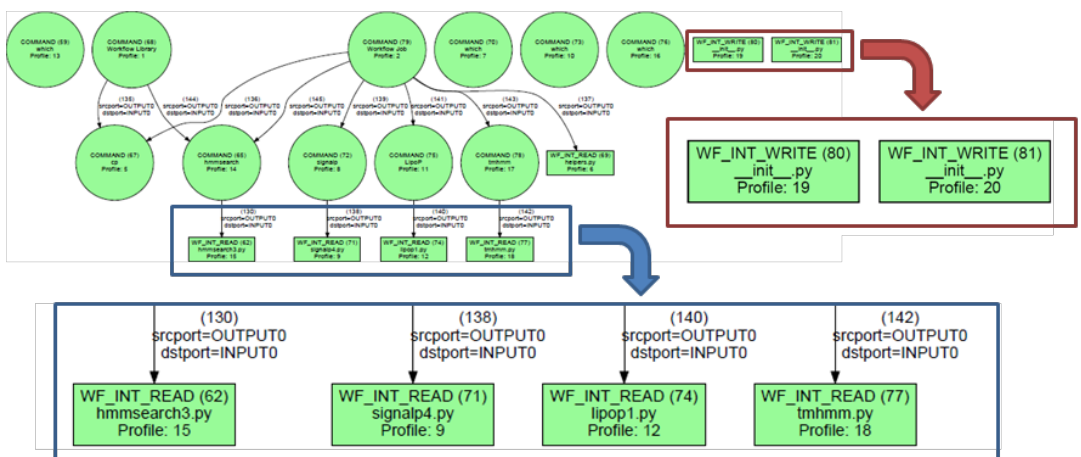
Figure 5: Skeletonized abstract data dependency graph for Inmembrane. The four events labeled by WF INT READ at the bottom of the figure are magnified in the bottom window whereas the two events labeled by WF INT WRITE at the top of the graph are shown magnified in the right window.